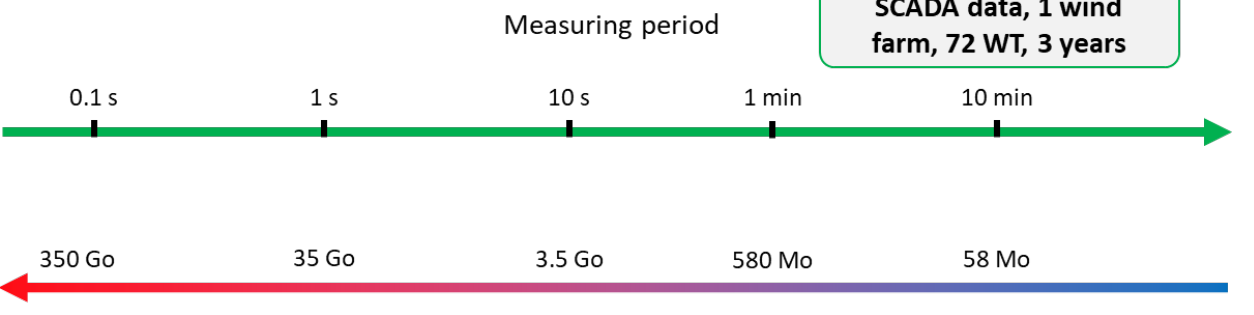
Figure 1. Schema showing the relation between data weight and the measuring period for a wind farm composed of 72 WT for a period of 3 years.